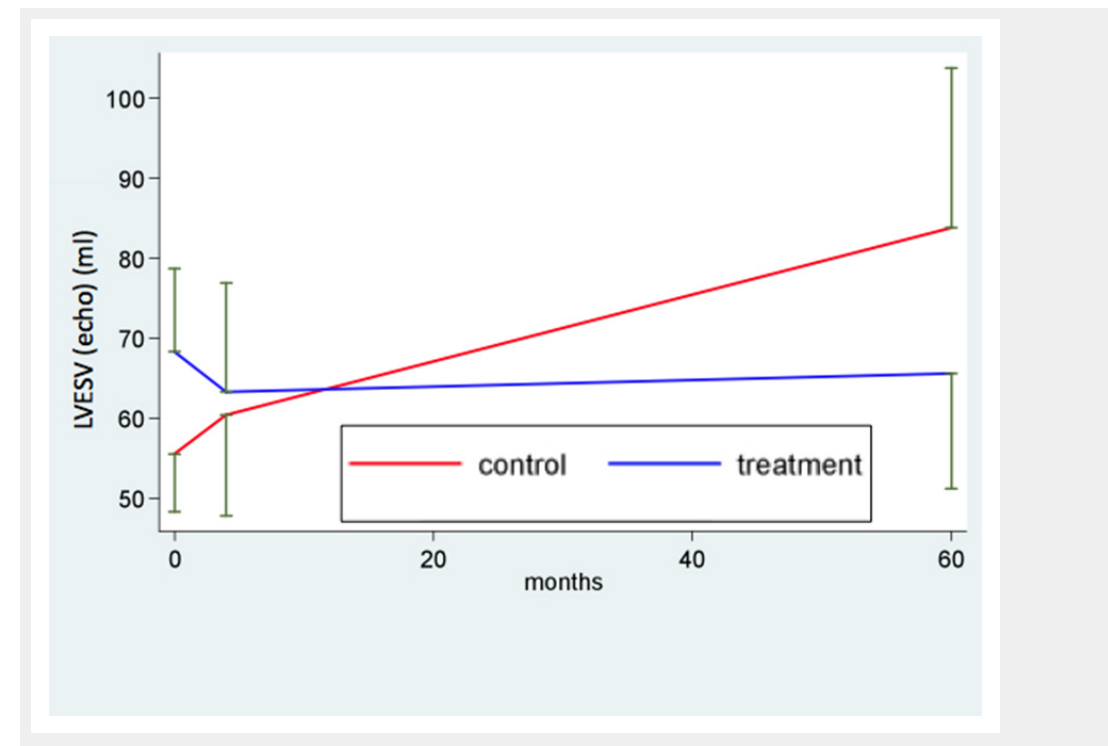
Figure 4 Left ventricular remodelling directly after myocardial infarction (baseline), after 4 and 60 months. LVESV: left ventricular endsystolic